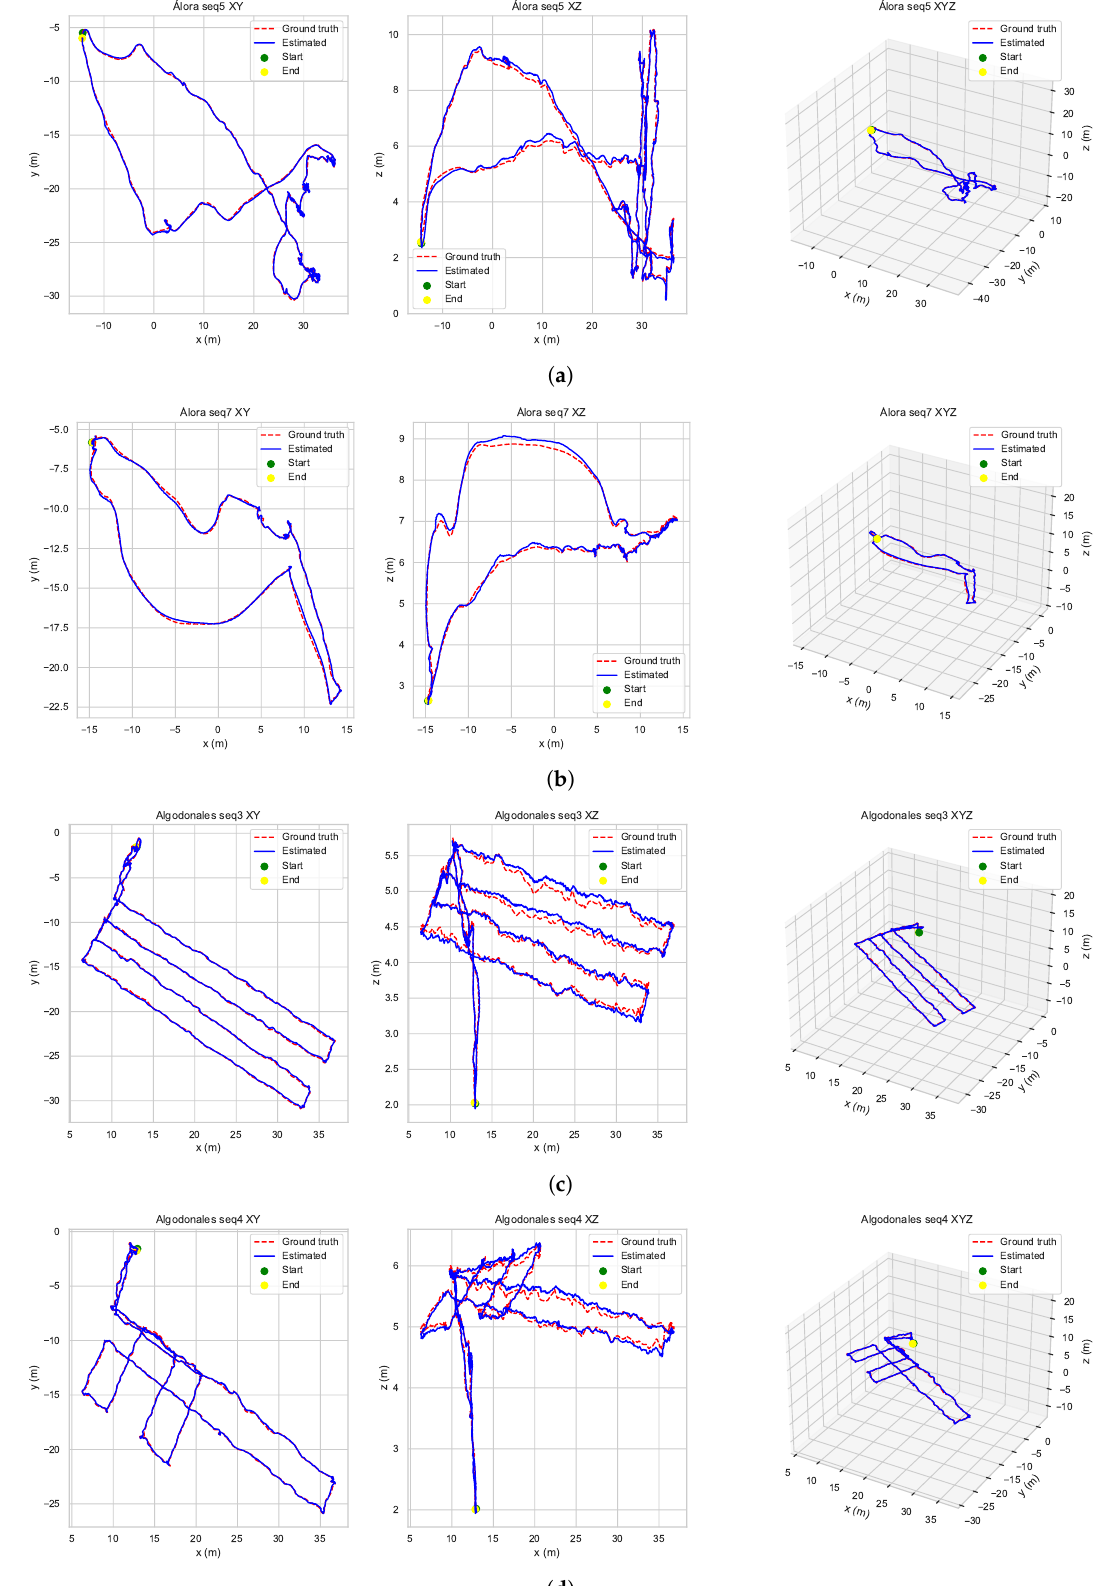
Figure 10. Examples of trajectories followed from take-off to landing. The maneuvers were performed under a deck of the Algodonales and Álora viaducts. The graphs on the left illustrate X-Y, center X-Z and right X-Y-Z. ( a ) Alora sequence 5, ( b ) Alora sequence 7, ( c ) Algodonales sequence 3, ( d ) Algodonales sequence